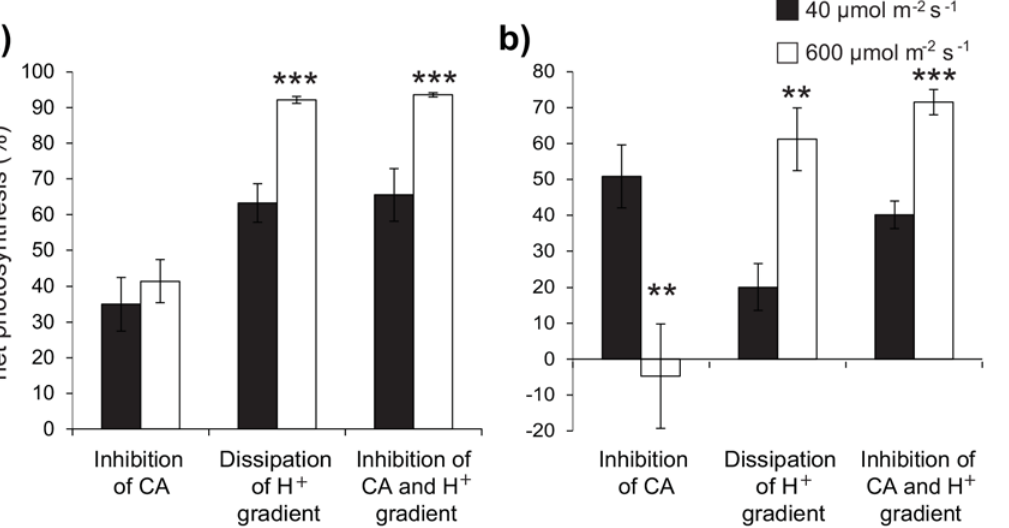
Fig 3. Reduction in net photosynthetic responses of (a) C . serrulata and (b) H . uninervis , when subjected to HCO 3 - uptake inhibitors. Net photosynthetic responses were expressed relative to control rates in normal seawater. 0.1 mM acetazolamide (inhibition of extracellular CA), 45 mM TRIS buffer at pH 8.0 (dissipation of H + gradient), and a combination of TRIS and acetazolamide (inhibition of CA and H + gradient). Asterisks indicate significant differences between light treatments for each inhibitor or inhibitor combination ( ** p < 0.01; *** p < 0.001). Means ( ± S.E) are given (n =